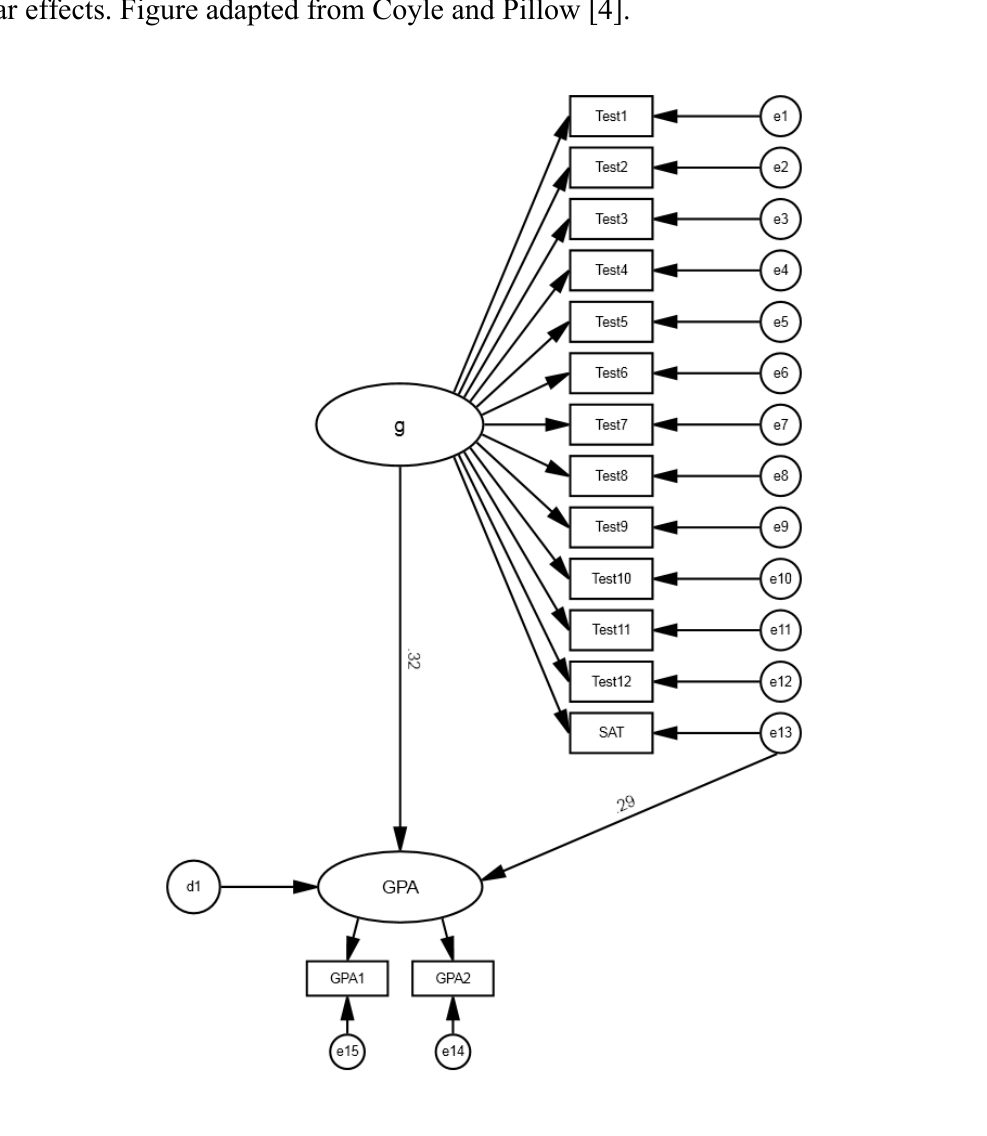
Figure 1. Relation of SAT non- g residuals with college GPA. g was based on the Armed Services Vocational Aptitude Battery (ASVAB), a diverse battery of 12 tests. The SAT residuals (e13) predicted GPA (beta = .29) almost as well as g (beta = .32), indicating that non- g factors influenced the predictive validity of the SAT. The ACT residuals produced similar effects. Figure adapted from Coyle and Pillow